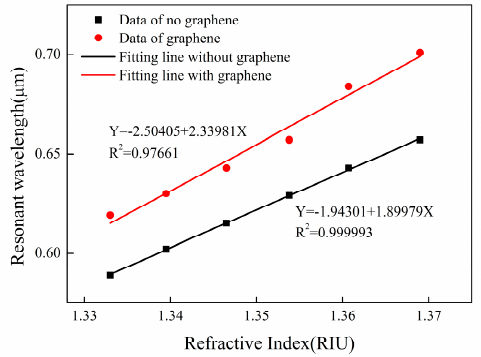
Figure 11. Fitting the experimental data of sensors with or without graphene.